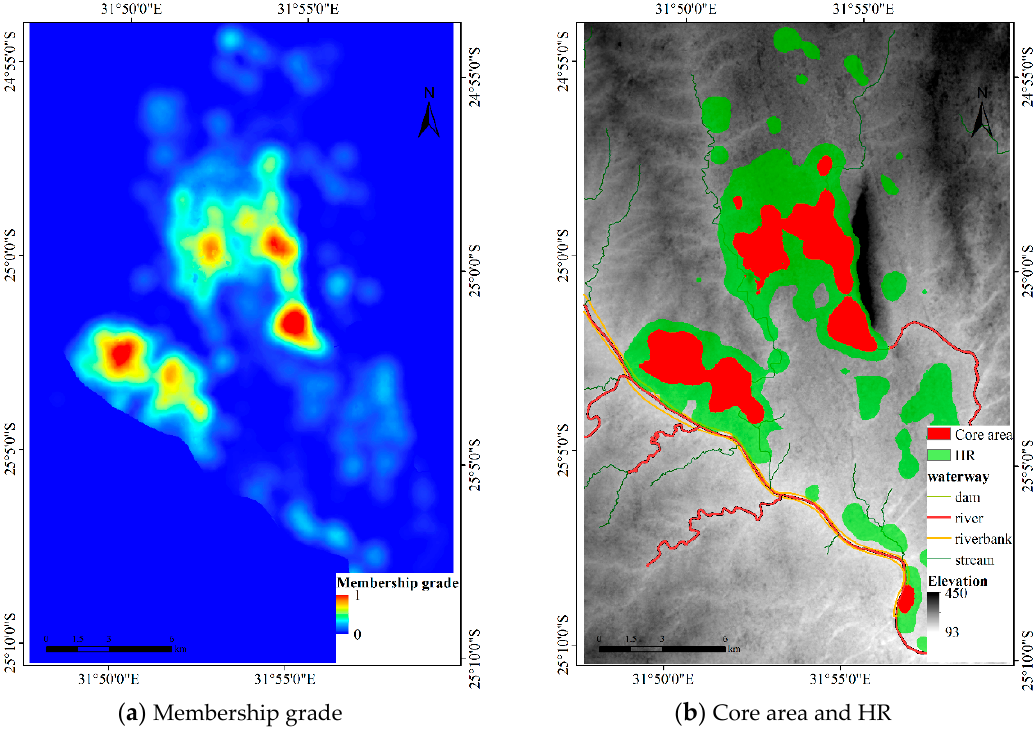
Figure 12. The membership grade, core areas and HR of Dataset 3.